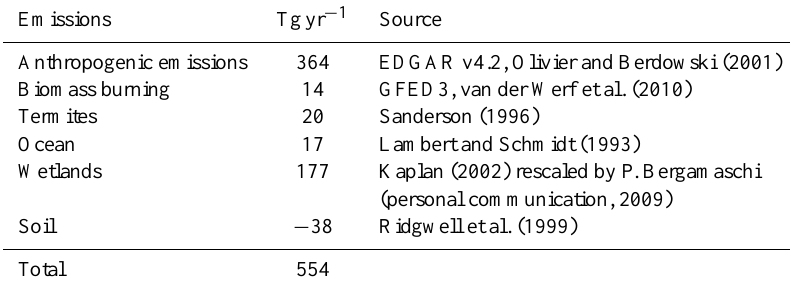
Table 1. Global annual prior methane emissions used in the